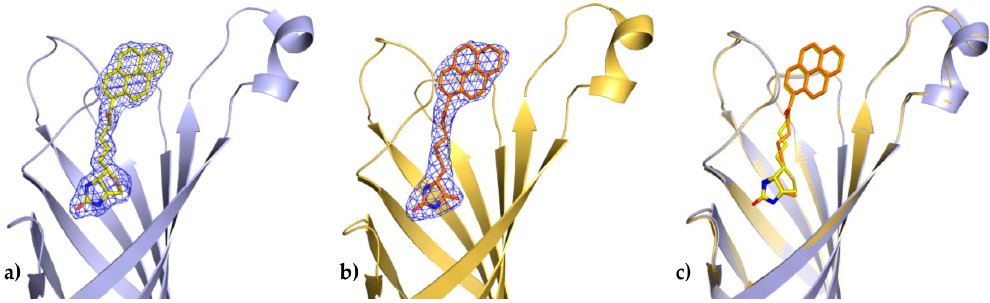
Figure 2. Binding site of avidin in molecule C. The coordinates of 1-biotinylpyrene ( a ) and 1-desthiobiotinylpyrene ( b ) superimposed on the final 2F o -F c electron density maps contoured at the 1 σ level; ( c ) Superposition of two avidin structures determined in this work.